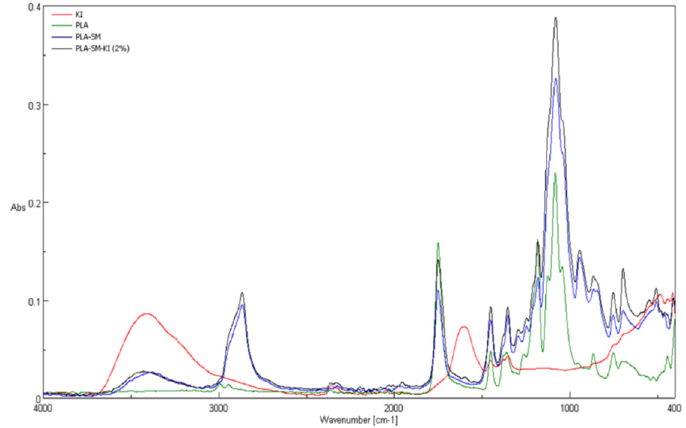
Figure 8. Attenuated Total Reflectance Fourier-Transform Infrared Spectroscopy (ATR-FTIR) spectra of PLA, PLA-SM, PLA-SM-KI (2%) and KI, range 400–4000 cm − 1 .